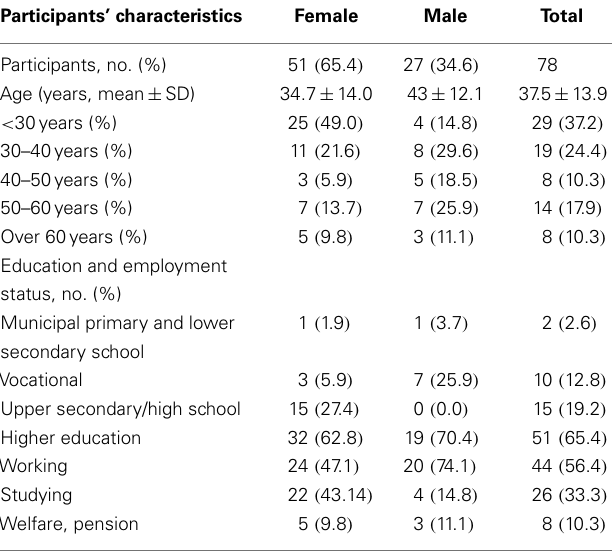
Table 1 | Participants’ characteristics